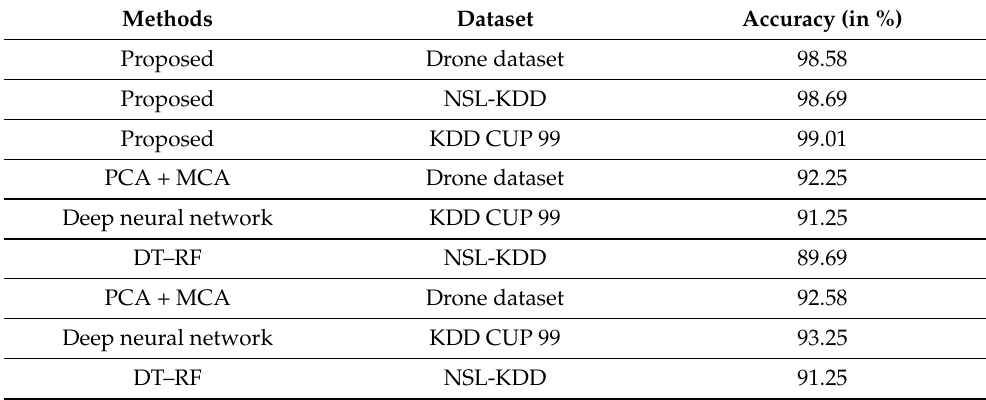
Table 8. Comparative